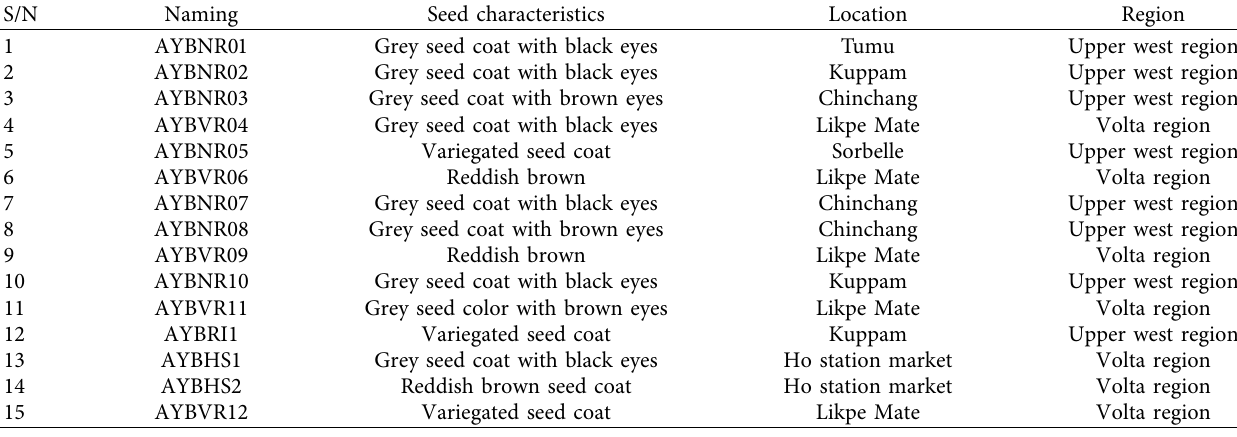
Table 1: Description of the African yam bean landraces and location of